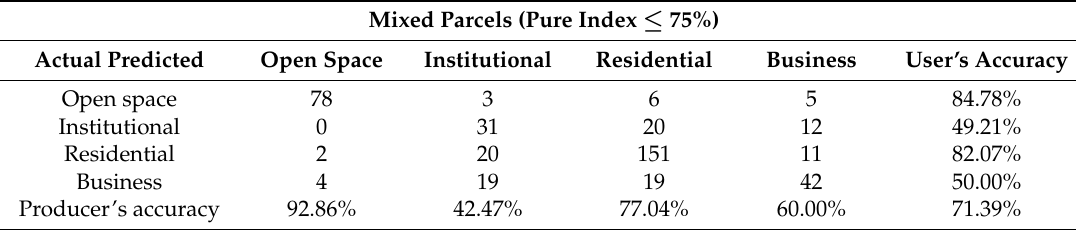
Table 5. Confusion matrices of urban land use classification using mixed and pure parcels.